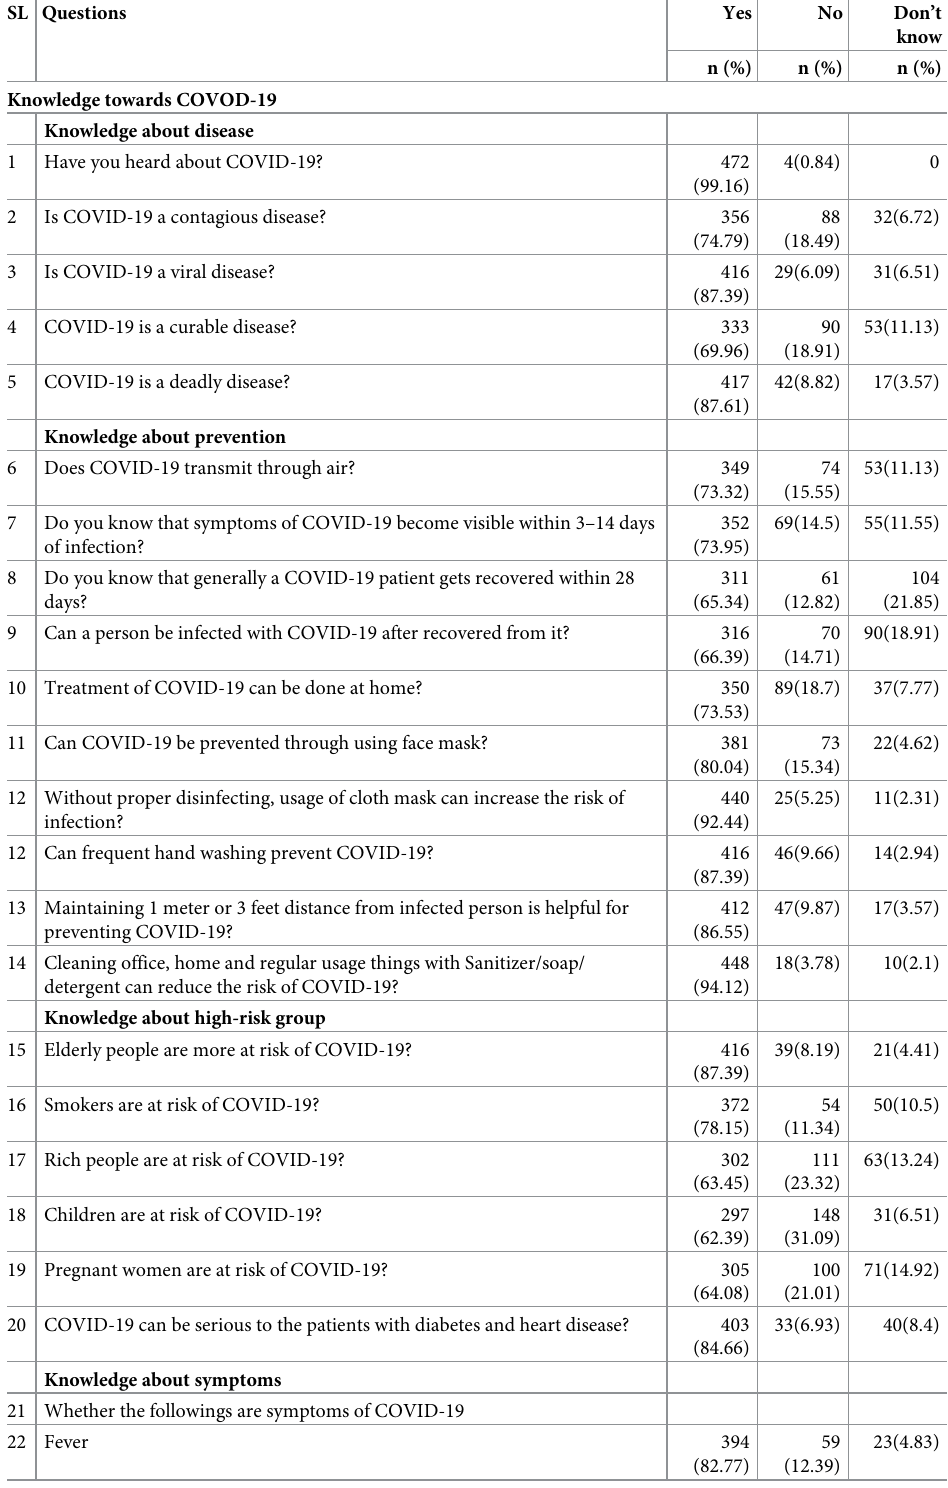
Table 2. Knowledge, attitude, and practice towards COVID-19 among the